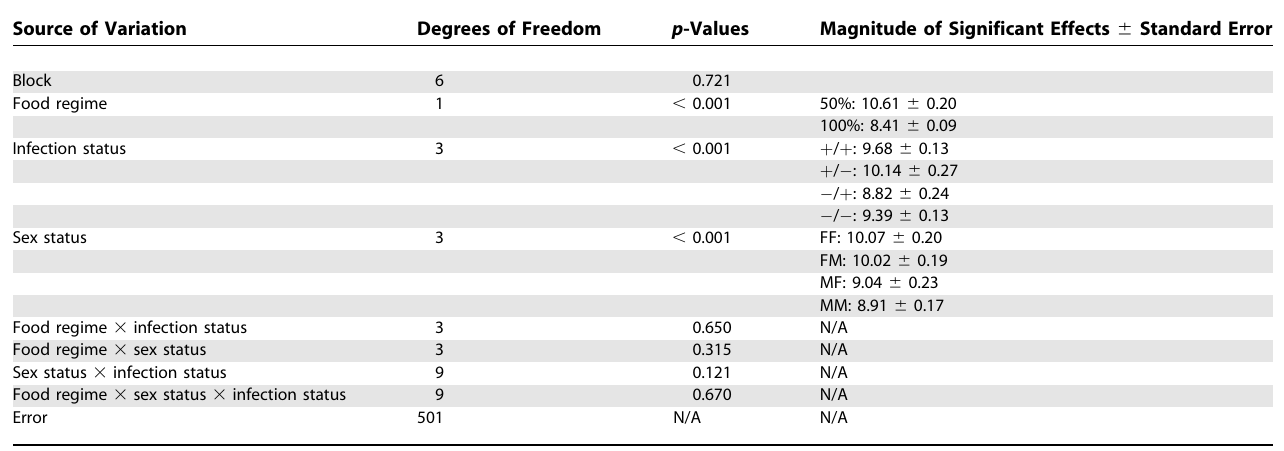
The p -valuescorrespondtotheupper95%quantileofthedistributionofthe p -valuesobtainedafterre-samplingofthedata200times.Inthe ‘‘ MagnitudeofSignificantEffects ’’ column,meansarethemeanvaluesoverthe200analyses,and standard errors are derived from 2.5% and 97.5% of the distribution of obtained means. þ / þ , infected versus infected competitor; þ / (cid:1) , infected versus uninfected control competitor; (cid:1) / þ , uninfected control versus infected competitor; (cid:1) / (cid:1) , uninfected control versus uninfected control competitor; FF, female versus female competitor; FM, female versus male competitor; MF, male versus female competitor; MM, male versus male competitor; N/A, not applicable. DOI: 10.1371/journal.pbio.0030262.t001